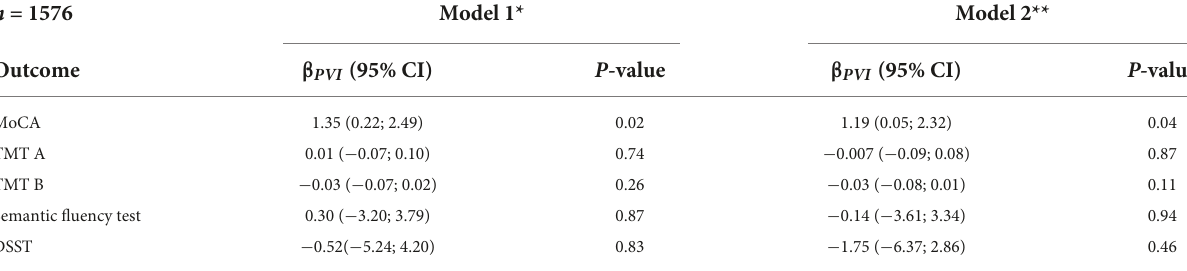
TABLE 3 Association between PVI and cognitive function using propensity score inverse probability of treatment weighting in patients without history of PVI. n = 1576 Model